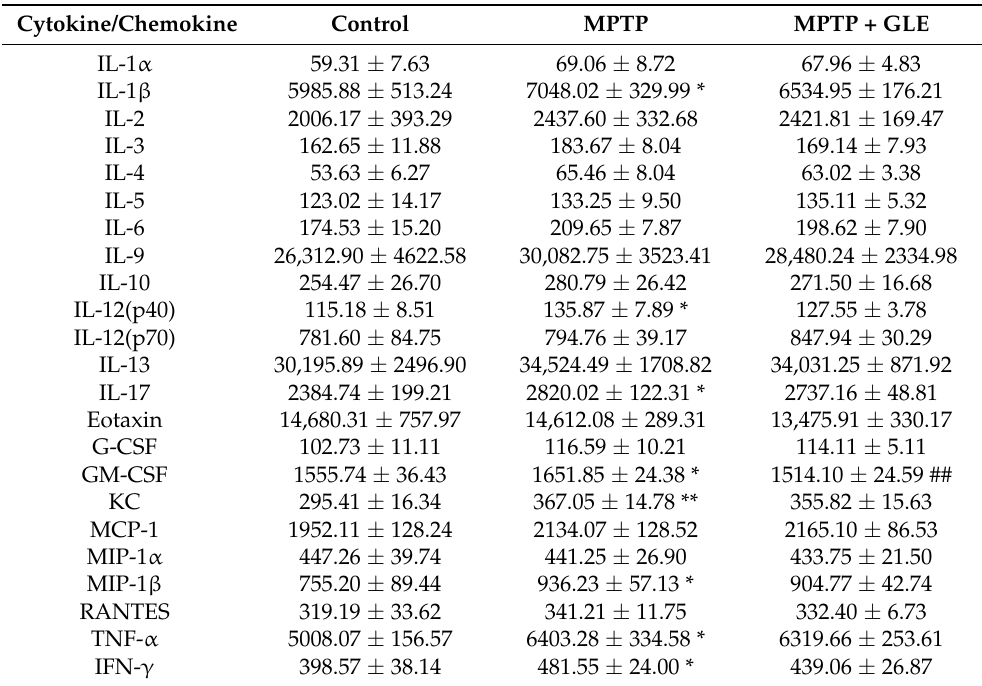
Table 1. Mouse midbrain cytokine/chemokine concentrations 1 .